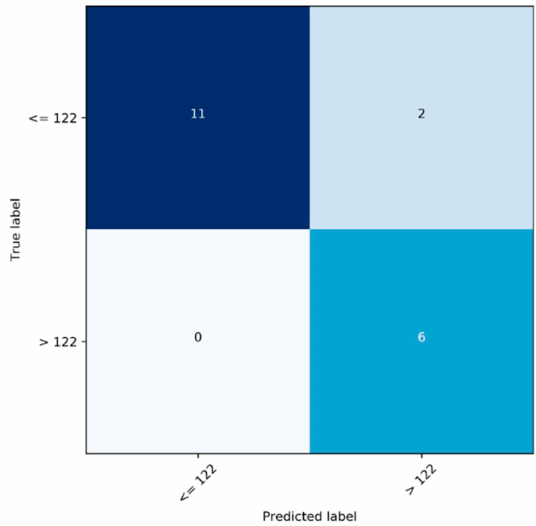
Figure 3. KNN algorithm at work with data from the Bronx (confusion